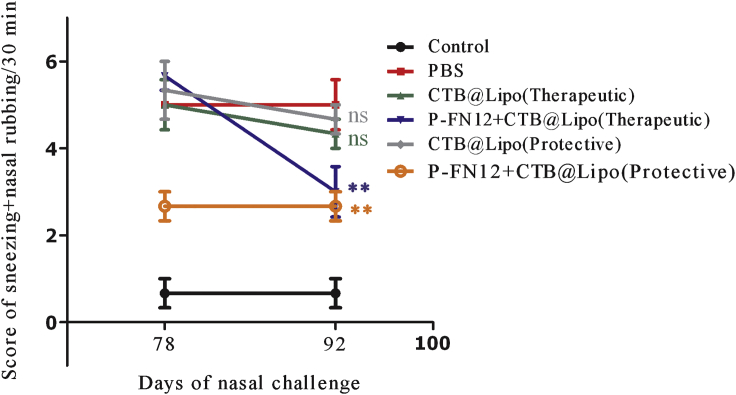
Nasal Symptom ScoresFrequency of nasal rubbing plus sneezing on days 78 and 92. The scores shown are the average of the involved mice’s scores in the group (n = 5). ns, not significant; **p < 0.01.